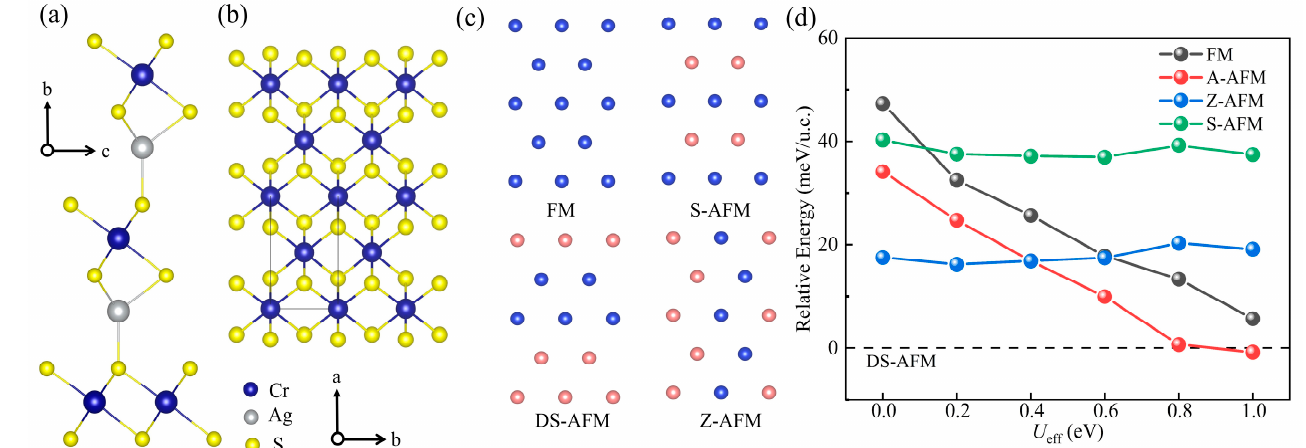
Figure 1. ( a , b ) Side view and top view of bulk AgCrS 2 . ( c ) Four in-plane magnetic configurations: ferromagnetic order (FM), stripe AFM (S-AFM), double-stripe order (DS-AFM), and zigzag AFM order (Z-AFM). Blue and red spheres indicate spin-up and spin-down Cr ions, respectively. The other ions are omitted for clarity. ( d ) The energy evolution of various magnetic orders as a function of U eff . The DS state energy is taken as the reference value.